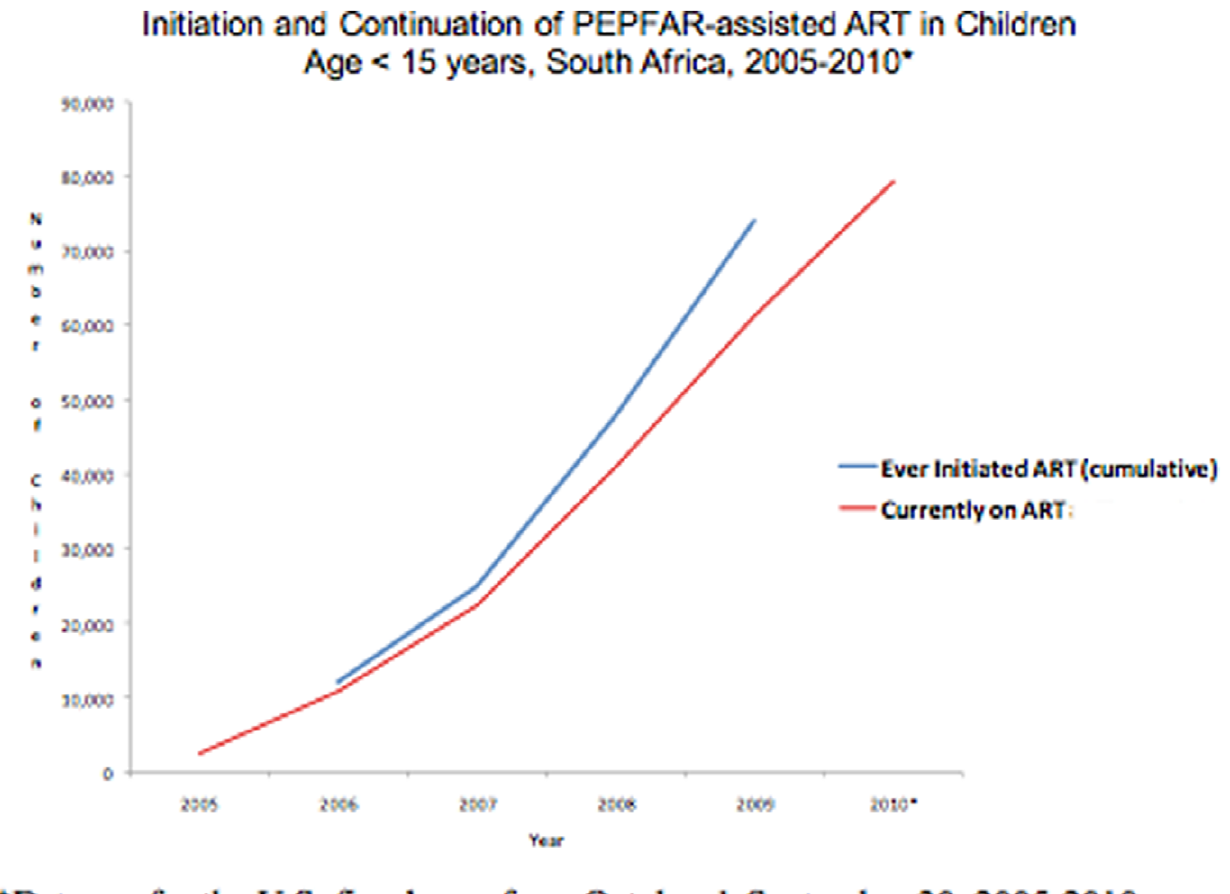
Figure 1. Initiation and Continuation of PEPFAR-assisted Antiretroviral Treatment (ART) in Children, South Africa, 2005–2010.